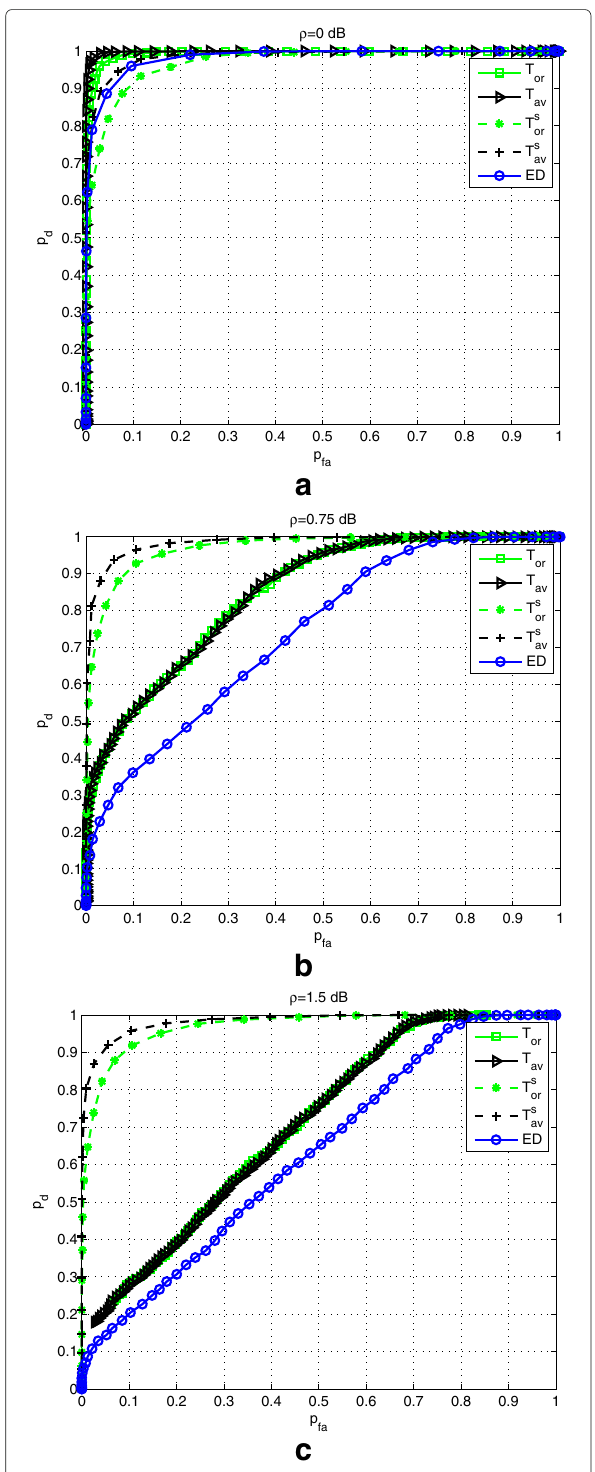
Fig. 12 ROC curves of the proposed schemes under various values of NU, N = 1000 samples, and SNR = -10 dB: Gaussian channel. a ρ = 0 dB. b ρ = 0.75 dB. c ρ = 1.5